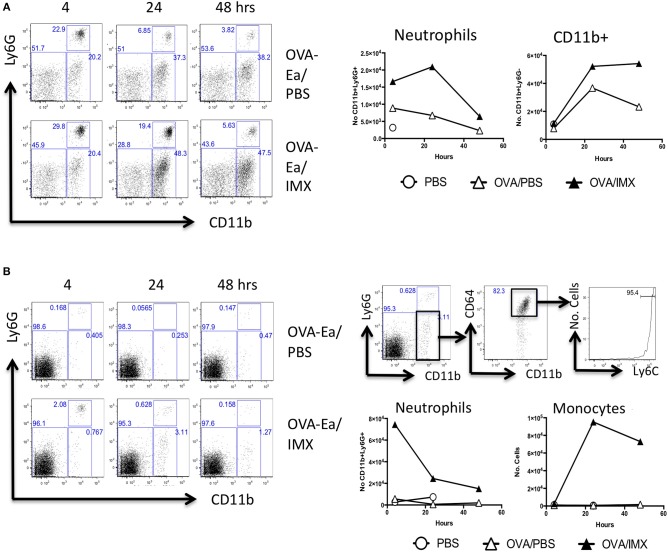
Neutrophils and CD11b+ cells are recruited to both the injection site and to the draining lymph node. (A) Representative flow cytometry plots showing the recruitment of neutrophils and CD11b+ cells in the injection site at 4, 24, and 48 h following immunization with OVA/PBS (top) or OVA/ISCOMATRIX (bottom). Absolute numbers are shown in the graphs on the right. (B) Representative flow cytometry plots showing the recruitment of neutrophils and CD11b+ cells in the draining cervical lymph node at 4, 24, and 48 h following immunization with OVA/PBS (top left) or OVA/ISCOMATRIX (bottom left). Further representative plots show the identification of the majority of the CD11b cells in the OVA/ISCOMATRIX treated lymph node at 24 h were monocytes (CD64+Ly6C high) (top right). Absolute numbers of Neutrophils and monocytes recruited to the draining lymph node in response to OVA/PBS and OVA/ISCOMATRIX are shown (bottom left). Data shown is from 3 mice per group pooled and is representative of 5 independent experiments. IMX = ISCOMATRIX™ adjuvant.